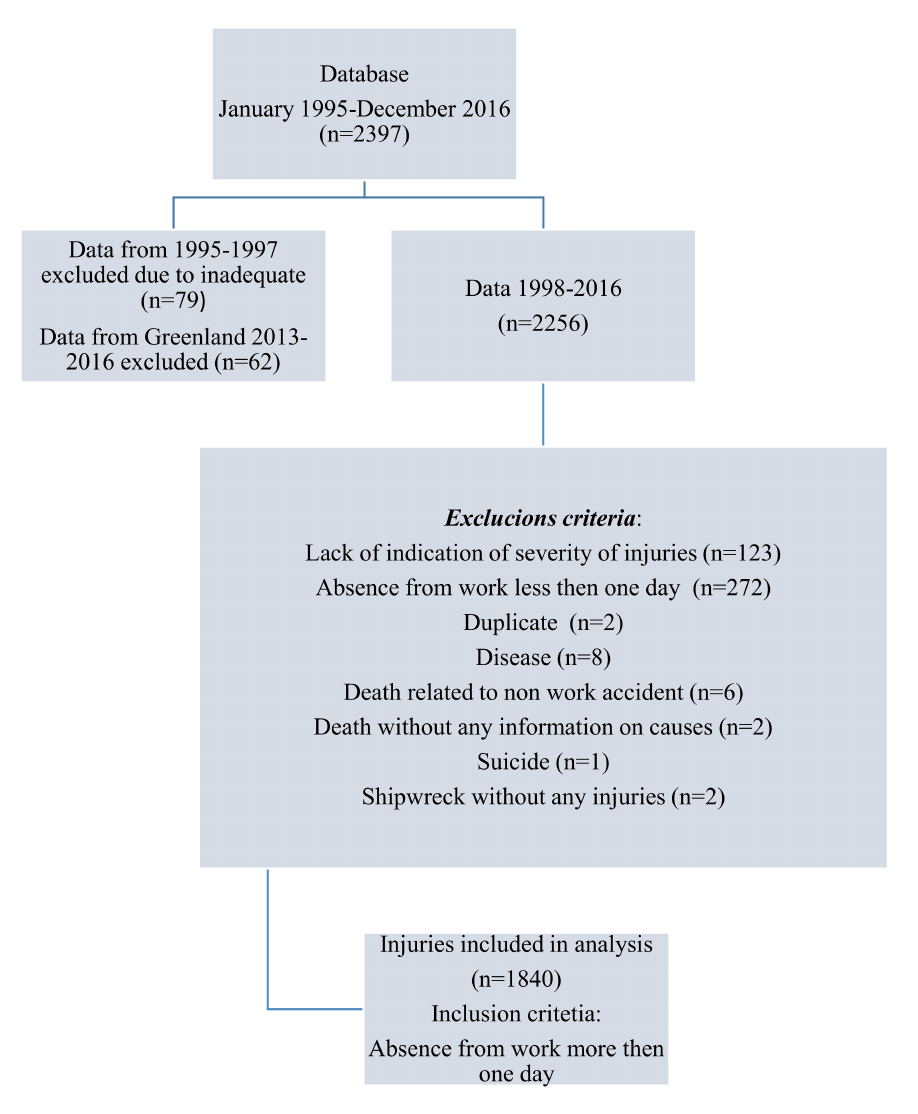
Figure 1. Flow chart illustrating the injuries chosen for